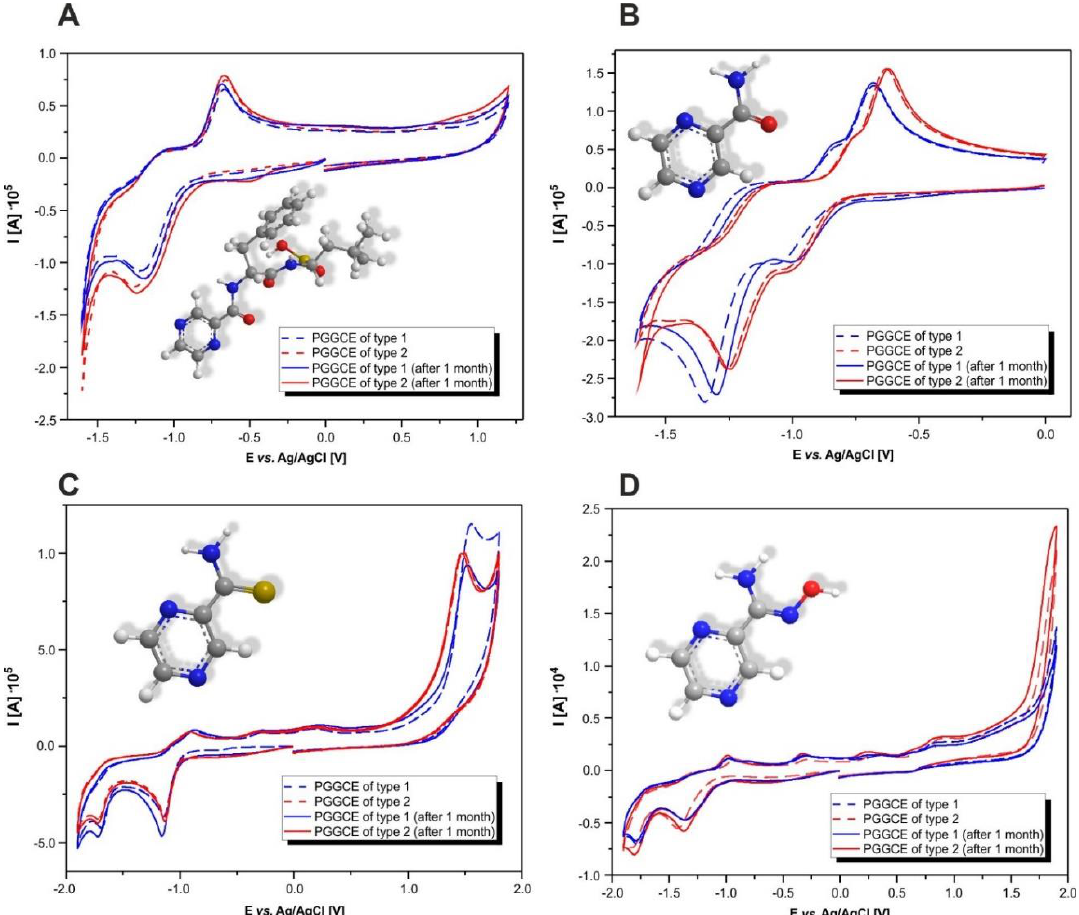
Figure 9. Cyclic voltammograms registered by PGGCEs sensors data to prove their stability (freshly prepared sensors as well as after one month since the modification) in analyses of solutions (NaClO 4 ): 1.25 mM of BZM ( A ), 2.00 mM of: PZA ( B ), PTCA ( C ), PAOX ( D ).